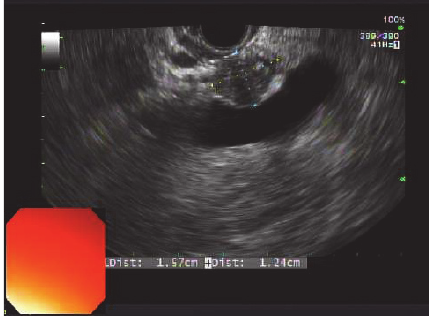
Figure 4: Histology of the resected tumor at a magnification of 100x showing abundant elastic